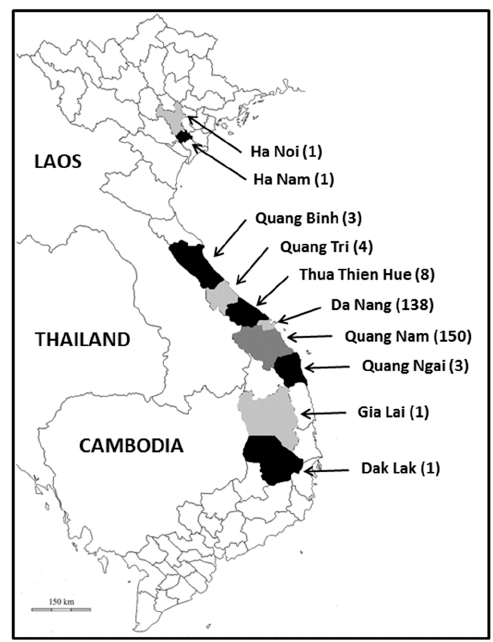
Figure 1. Map of Vietnam showing the place of residence of the subjects enrolled in this survey. The number of participants living in each province or municipality is indicated between brackets. A total of 310 patients, followed for di ff erent pathologies or routine examinations and presenting or not digestive disorders, were enrolled. These patients were originally from 10 provinces or municipalities in Vietnam, but the large majority of them lived in the Da Nang municipality (138/310, 44.5%) and the neighboring province of Quang Nam (150/310, 48.4%) (Figure 1). Stool samples (1 sample per patient) were collected during routine clinical proce- dures. For each subject, approximately 2 g of fresh stool was added to 2 mL of 2.5% po- tassium dichromate ( w / v in water) (Sigma Life Sciences, Saint Louis, MO, USA) in a ster- ile Falcon tube, then mixed vigorously for homogenization before storage at 4 °C. The samples were subsequently transferred to the Pasteur Institute of Lille (France) for fur- ther processing. 2.3. DNA Extraction, PCR Assays and Molecular Subtyping/Genotyping of Blastocystis sp. Isolates Upon arrival in France, the fecal specimens were washed 3 times with distilled wa- ter by centrifugation at 3000 g for 10 min to remove any trace of potassium dichromate. The last supernatant was discarded, and the resulting ultimate pellet was diluted in 500 µL of sterile water. The total genomic DNA was extracted from the diluted pellet using the NucleoSpin 96 Soil kit or NucleoSpin Soil, Mini kit for DNA from Soil (Ma- cherey-Nagel GmbH & Co KG, Düren, Germany), following the recommended proce- dures of the manufacturer. DNA was eluted in 100 µL of elution bu ff er provided in the kits and stored at − 20 °C. The Blastocystis -speci fi c primers BL18SPPF1 (5 ′ -AGTAGTCATACGCTCGTCTCAAA-3 ′ )